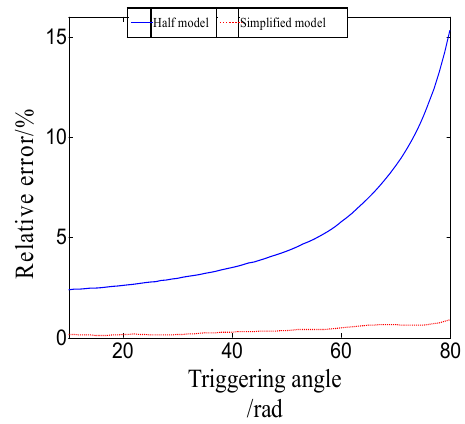
Figure 7. Error analysis of models.